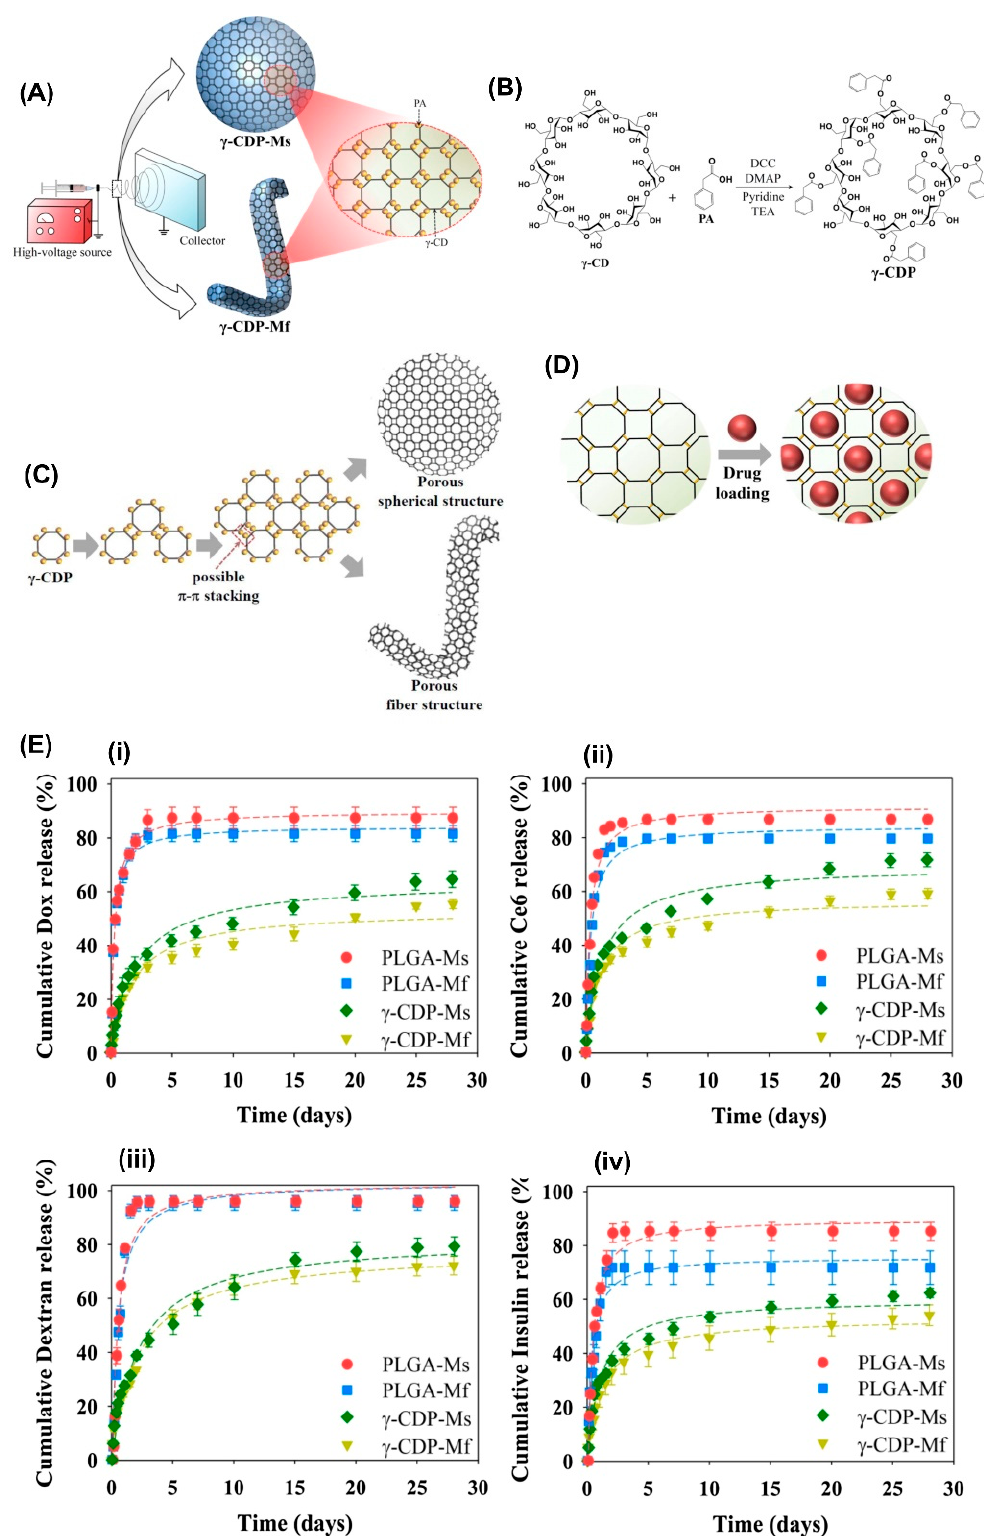
Figure 8. ( A ) A schematic representation of the electrospinning and electrospraying of γ -CyDPs. ( B ) The synthesis pathway of γ -CyDP. ( C ) Cartoon schemes of γ -CyDP-microspheres (Ms) or γ -CyDP microfibers (Mf) with porous structure and ( D ) their drug loading. ( E ) The cumulative molecule ( i ) Dox, ( ii ) Ce6, ( iii ) dextran, and ( iv ) insulin release (wt. %) from PLGA-Ms, PLGA-Mf, γ -CyDP-Ms, and γ -CyDP-Mf ( n = 3). The figure was reproduced from [182] with the permission of Elsevier, 2018.